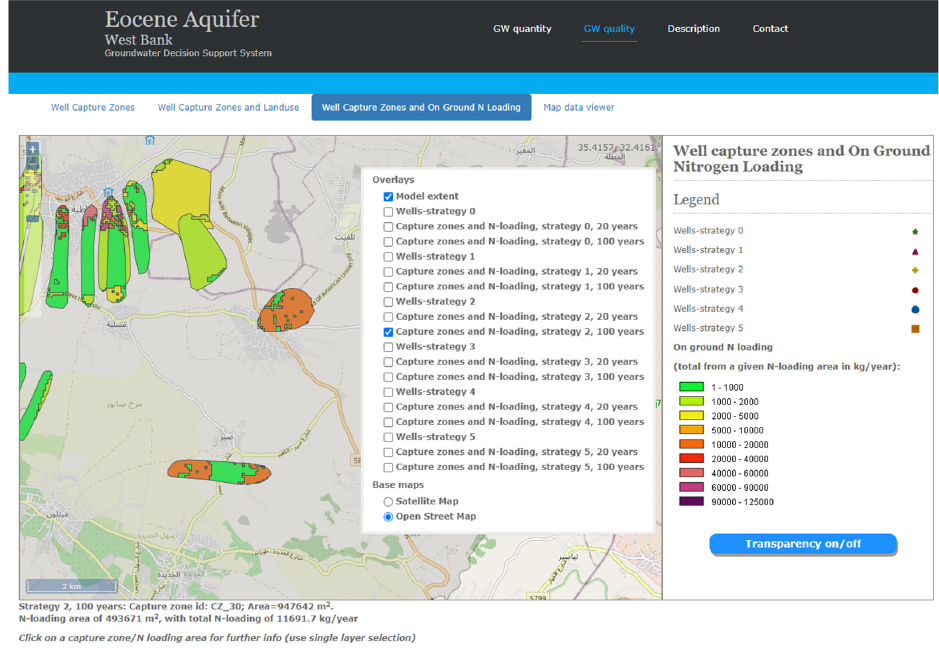
Figure 32. On-ground nitrogen loading within wells capture zones for strategy 03.